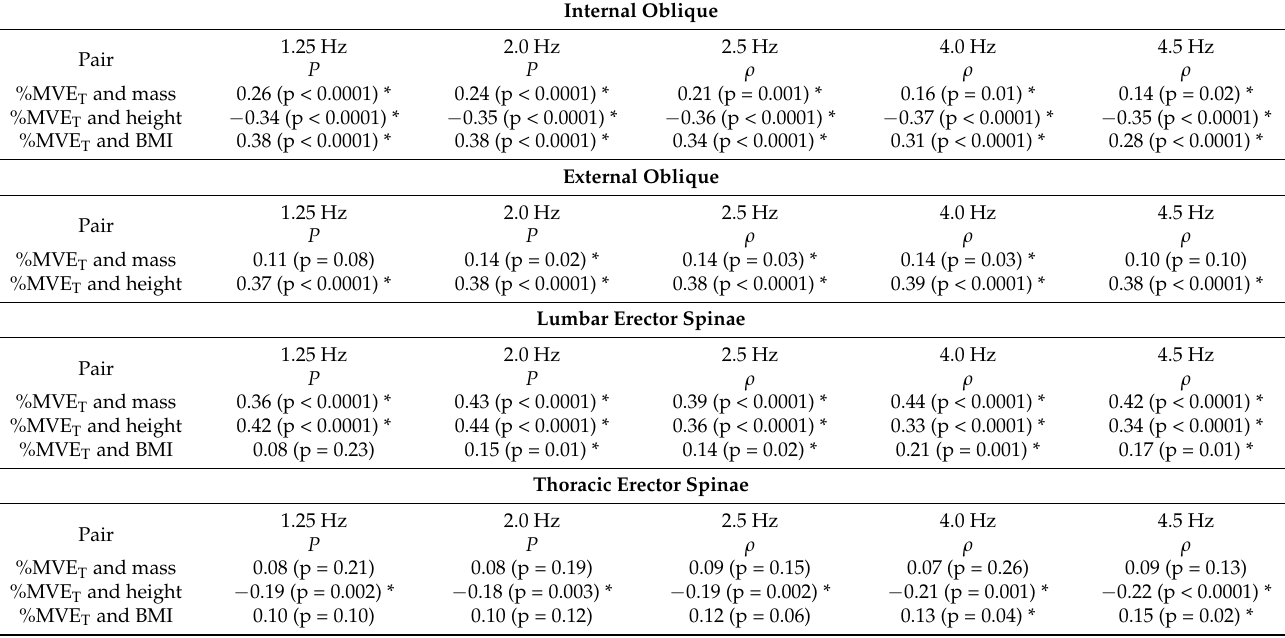
Table 1. Spearman’s rank coefficient of correlation ( ρ ) for pairwise comparison of BMI (body mass index), mass, and height with %MVE T (transformed % maximum voluntary electrical activation data) in the internal oblique, external oblique, lumbar erector spinae and thoracic erector spinae prior to back muscle fatigue. Spearman’s rho ( ρ ) values denoted with * are statistically significant.